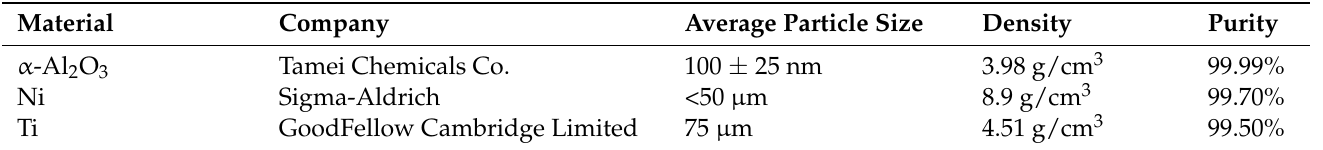
Table 1. Specification of the powders used in the research based on the manufacturer’s data.